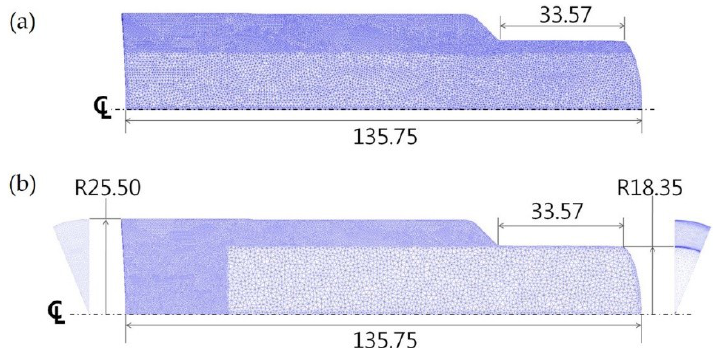
Figure 7. Re-constructed mesh structure of preform for forward-backward extrusion simulation (unit: mm): ( a ) Mesh structure of preform obtained by forward extrusion simulation; ( b ) Re-arranged mesh structure of preform for forward-backward extrusion.